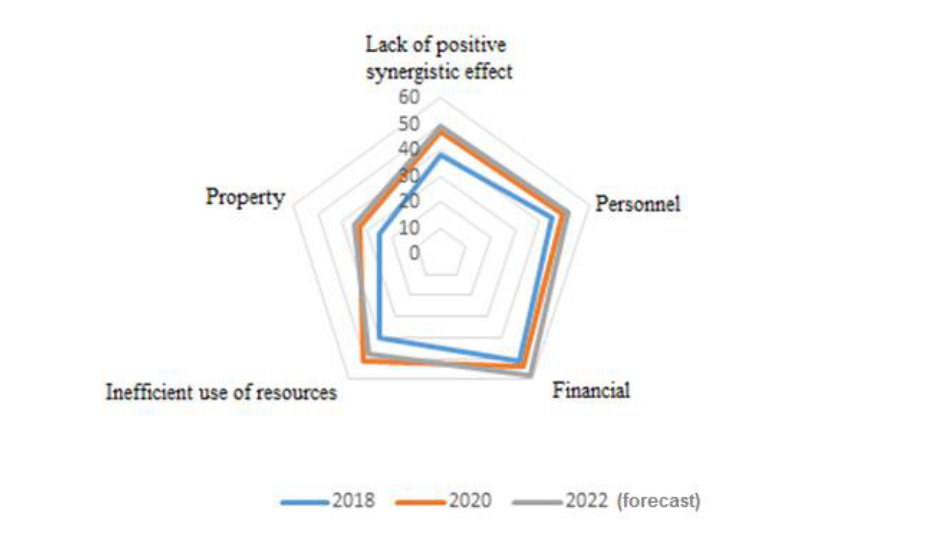
Figure 5. The results of the assessment of the group of cluster risks of the enterprises of the cluster. Developed by Izmalkova I. and Vertakova Yu.